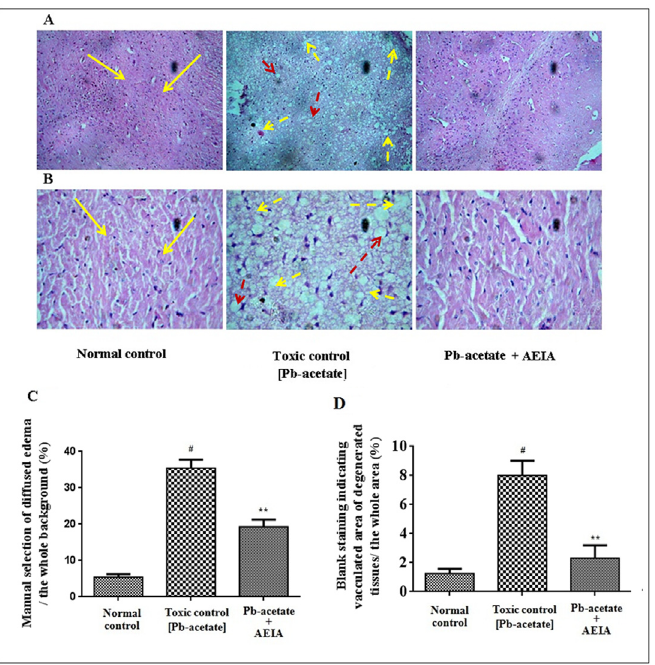
Fig 10. Histological sections 100 x (A) and 400 x (B) of brains of experimental mice in the absence (Pb- acetate) and existence of AEIA (Pb-acetate + AEIA). Untreated mice were kept as normal control to compare the structural changes caused by Pb-acetate. Yellow arrows represent normal normal cyto- architecture of brain; dotted arrows represent the Pb-acetate mediated development of vacuolated area of degenerated tissues (yellow) and diffused edema (red). C. The manually selected area of diffused edema relative to the whole area of the photomicrograph (400 x, randomly selected areas). D. The blank staining representing vacuolated area of degenerated tissues relative to the whole area of the photomicrograph (400 x, randomly selected areas). Values are expressed as mean ± SE, (n = 60). # Values differ significantly from normal control (p < 0.01). ** Values significantly differed from Pb-acetate control (p <